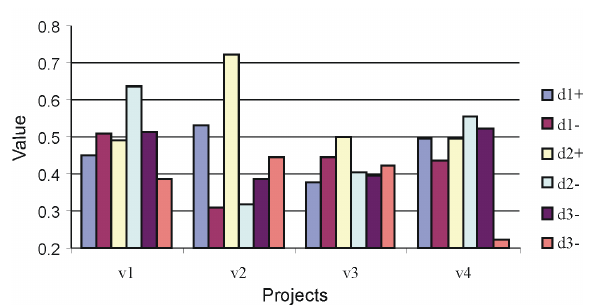
Fig.7. Calculation results according to TOPSIS grey method